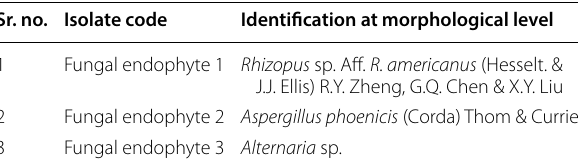
Table 1 Identification of the endophytic fungal isolates of P.